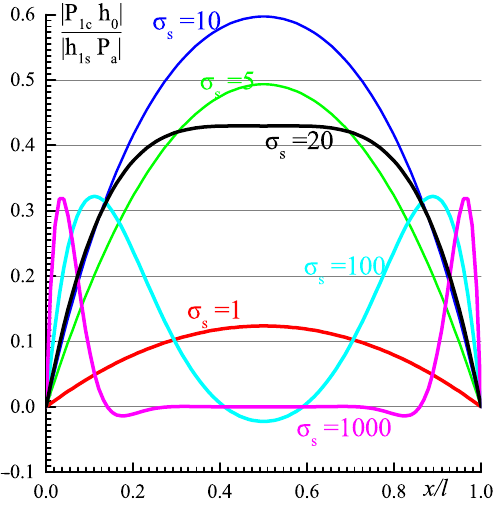
Figure 3. Distribution of P 1c inside the 1D parallel